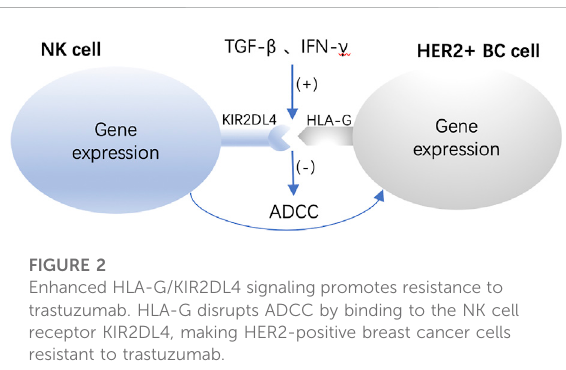
FIGURE 2 Enhanced HLA-G/KIR2DL4 signaling promotes resistance to trastuzumab. HLA-G disrupts ADCC by binding to the NK cell receptor KIR2DL4, making HER2-positive breast cancer cells resistant to